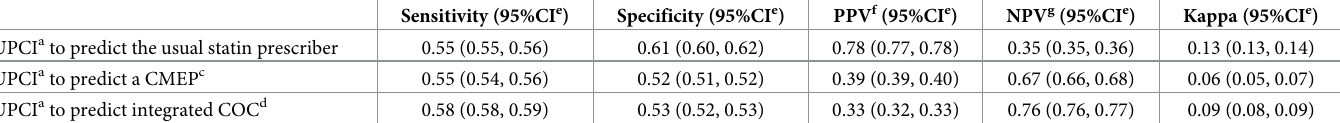
Table 2. Measures of accuracy using UPCI a to predict USP b , CMEP c , and integrated COC d